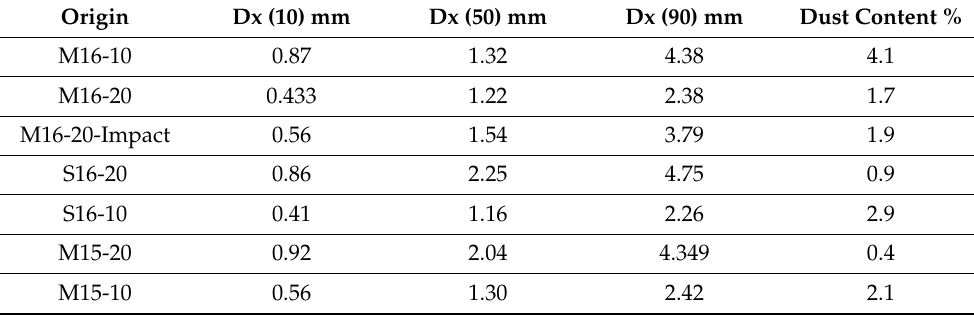
Table 3. Particle size distribution of rapeseed straws. Origin